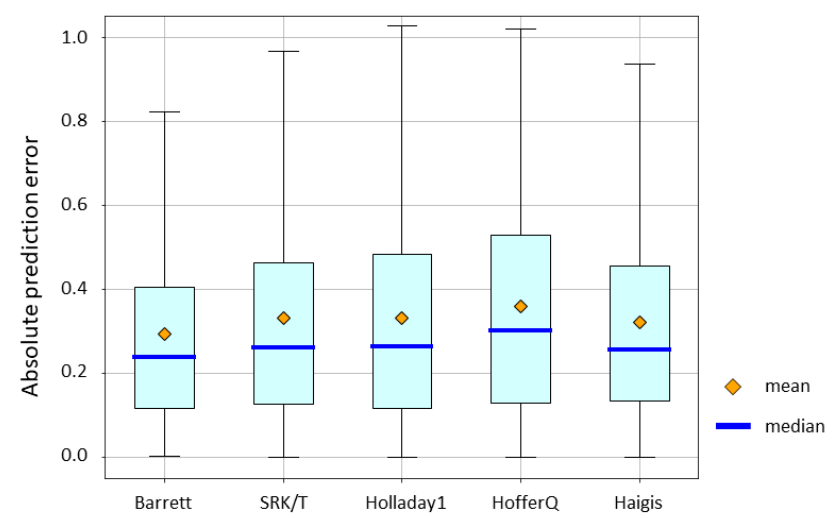
Figure 3. Mean absolute prediction error of conventional IOL power calculation formulae. Mean absolute error for the Barrett Universal II formula, SRK/T formula, Holladay 1 formula, Hoffer Q formula, and Haigis formula were 0.2960, 0.3314, 0.3312, 0.3602, and 0.3210, respectively. The p -value by the Friedman test was < 0.0001. The SRK/T formula vs. the Barrett Universal II formula: p = 0.0002. The Holladay 1 formula vs. the Barrett Universal II formula: p = 0.0004. The Hoffer Q formula vs. the Barrett Universal II formula: p < 0.0001. The Haigis formula vs. the Barrett Universal II formula: p = 0.0013. (The p-values were calculated using the Wilcoxon signed-rank test and were adjusted using the Bonferroni correction)